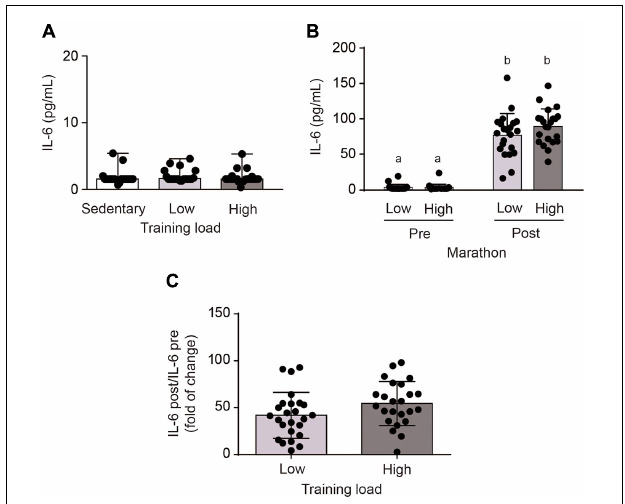
FIGURE 1 | Plasma interleukin-6 (IL-6) levels in sedentary subjects and athletes with high (HT) and low (LT) training loads. HT-group: ≥ 100 km by week, n = 22; LT group: < 100 km by week, n = 22; and a healthy and inactive physically group (control, CT; n = 21). (A) Basal venous blood samples were obtained 1 week prior to the marathon. After performing an outlier analysis using the ROUT method ( Q = 10%), two values in the LT group (corresponding to 11.3 and 18.8) and 1 value in the HT group (corresponding to 23.5) were discarded. Data were analyzed by one-way ANOVA followed by post hoc Holm-Sidak’s multiple comparisons test. (B) Post-exercise venous blood samples were obtained at the finish line within 5 min of the end of the marathon. Different letters indicate significant differences from different groups at the same time. Data were analyzed by two-way ANOVA followed by post hoc Sidak test; a vs. b p < 0.0001. (C) Changes in plasma IL-6 levels. After performing an outlier analysis using the ROUT method ( Q = 10%), a single value in the HT group (corresponding to 316) was discarded. Data were analyzed by Student t -test. Plasma IL-6 levels were determined using an ELISA kit. All data are presented as mean ± SD.